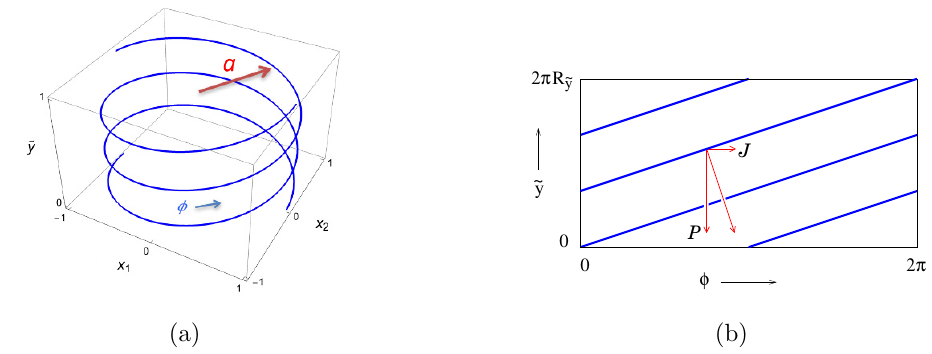
Figure 4. Source for the round NS5-P supertube. (a) A single BPS source with n 5 = 2 and k = 3; (b) Unrolling the circle of radius a reveals a (cid:12)vebrane source moving transversely to its worldvolume on the ~ y - (cid:30) torus. The (cid:12)vebrane winds along the ( n 5 ; k ) cycle of this